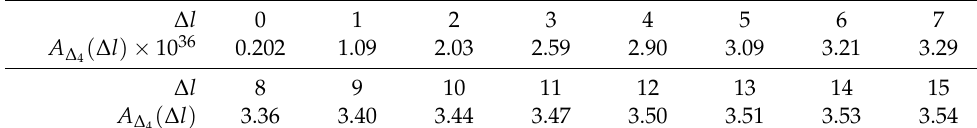
( ∆ l ) in function of the cut-off. 4